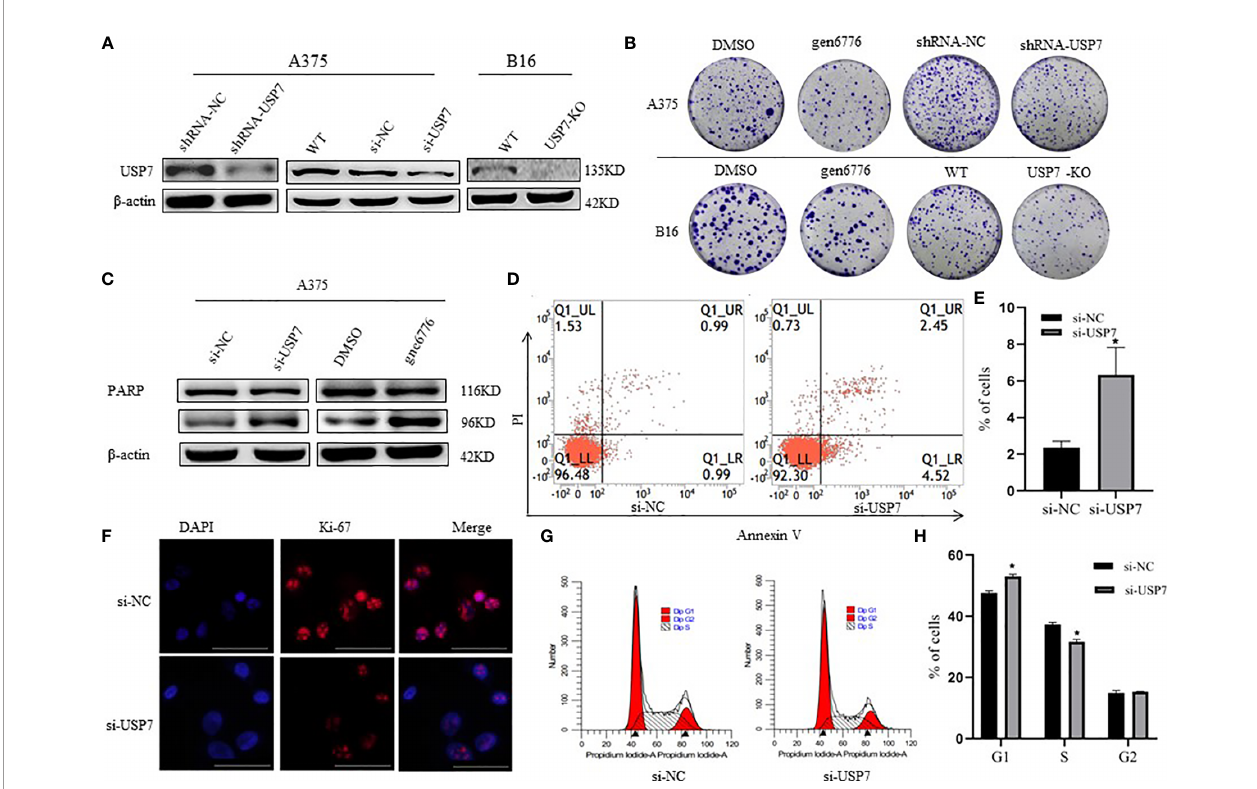
FIGURE 2 | Effects of USP7 on melanoma cell line growth. (A, B) Protein lysates were extracted from A375 cells transiently expressing USP7 siRNA and stable control shRNA or USP7 shRNA and B16 cells deleted the USP7 gene using the CRISPR/Cas9 editing system (USP7 KO). Western blotting analysis was performed to determine the expression of USP7. (B) Cells were collected from the indicated cells with gen6776 (USP7 inhibitor), USP7 shRNA or USP7 knockout treatment. Colony formation assay was performed and representative images are shown. (C – E) A375 cells were transfected with USP7 siRNAs for 48 h and detected with Annexin V-FITC/PI staining followed by fl ow cytometry analysis. Cell death populations are shown. Western blotting analysis was used for PARP expression. (F – H) A375 cells were treated as described in (C – E) . Immuno fl uorescence staining of Ki-67 of A375 cells was observed using fl uorescence microscope. Red: Ki-67; blue: nucleus. Typical images are shown. Scale bars: 50 m m. Analysis of cell cycle by FCM is described in the Materials and Methods. Data are represented as the mean ± SEM of three independent experiments, each in triplicate; bars, SEM. *P ≤ 0.05 vs.